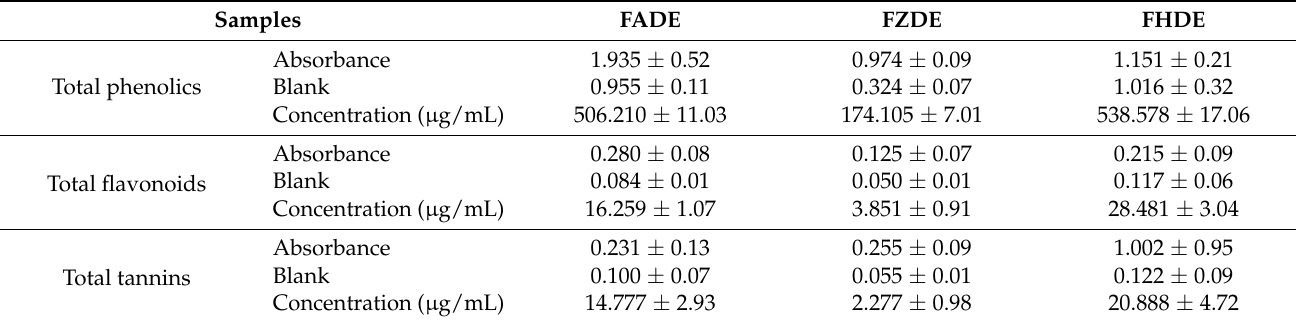
Table 5. Total phenolic, flavonoid, and tannin concentrations of the tested extracts.